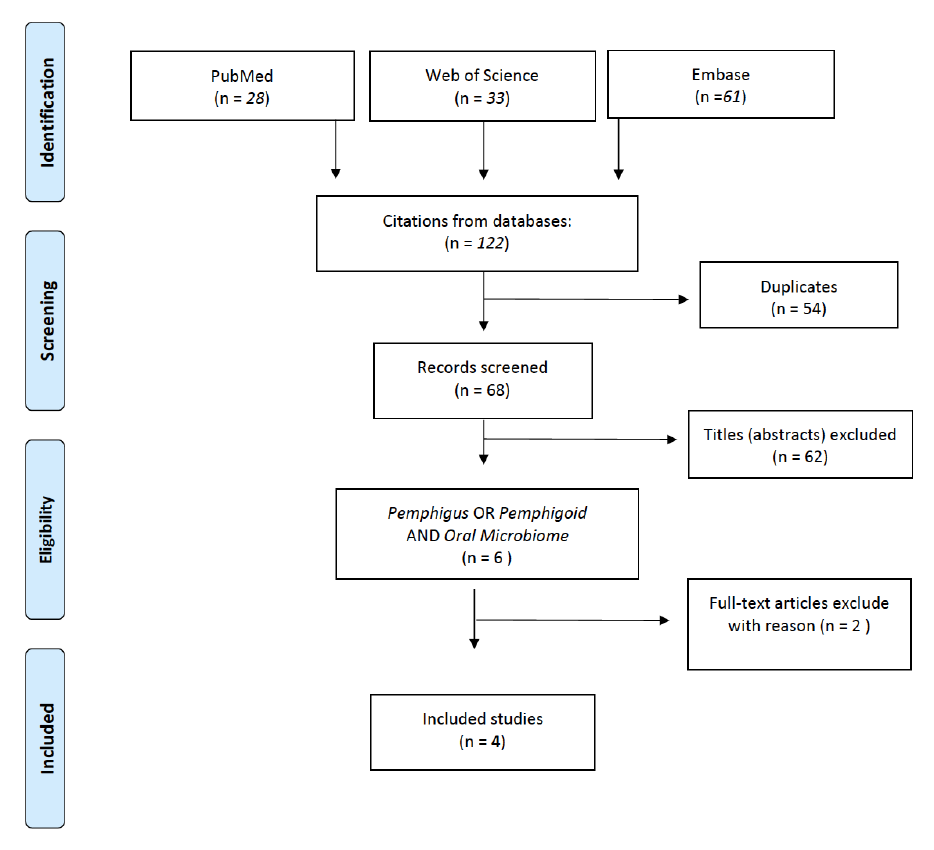
Figure 2. PRISMA Figure 2. PRISMA flowchart.